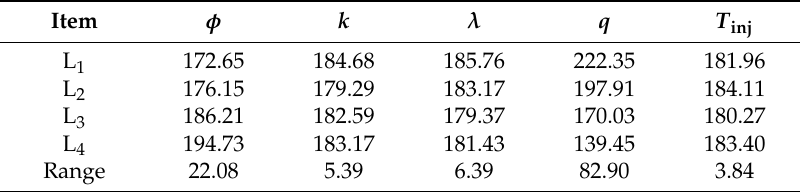
Table 5. Mean effects of different levels of conditions on the production temperature at t = 20 years.